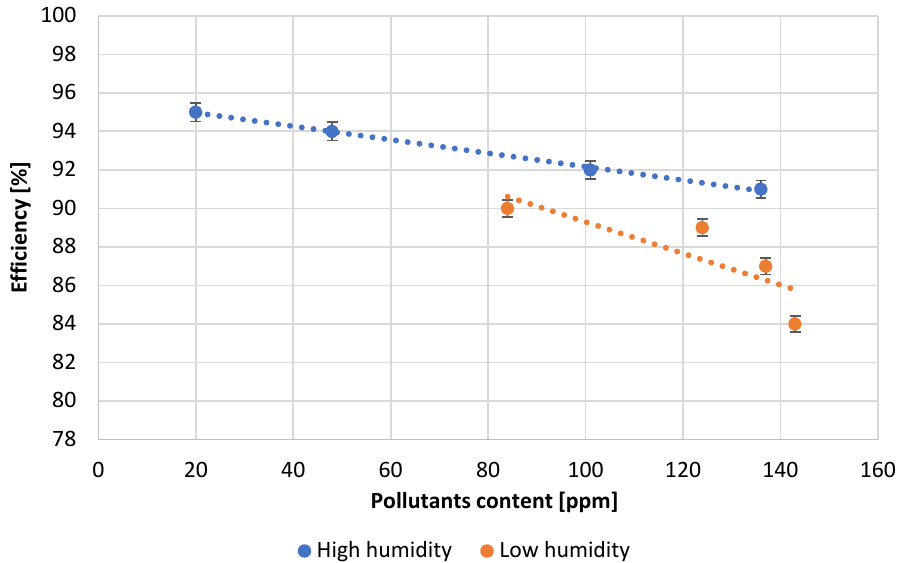
Figure 7. Dependence of process efficiency on pollutants content.